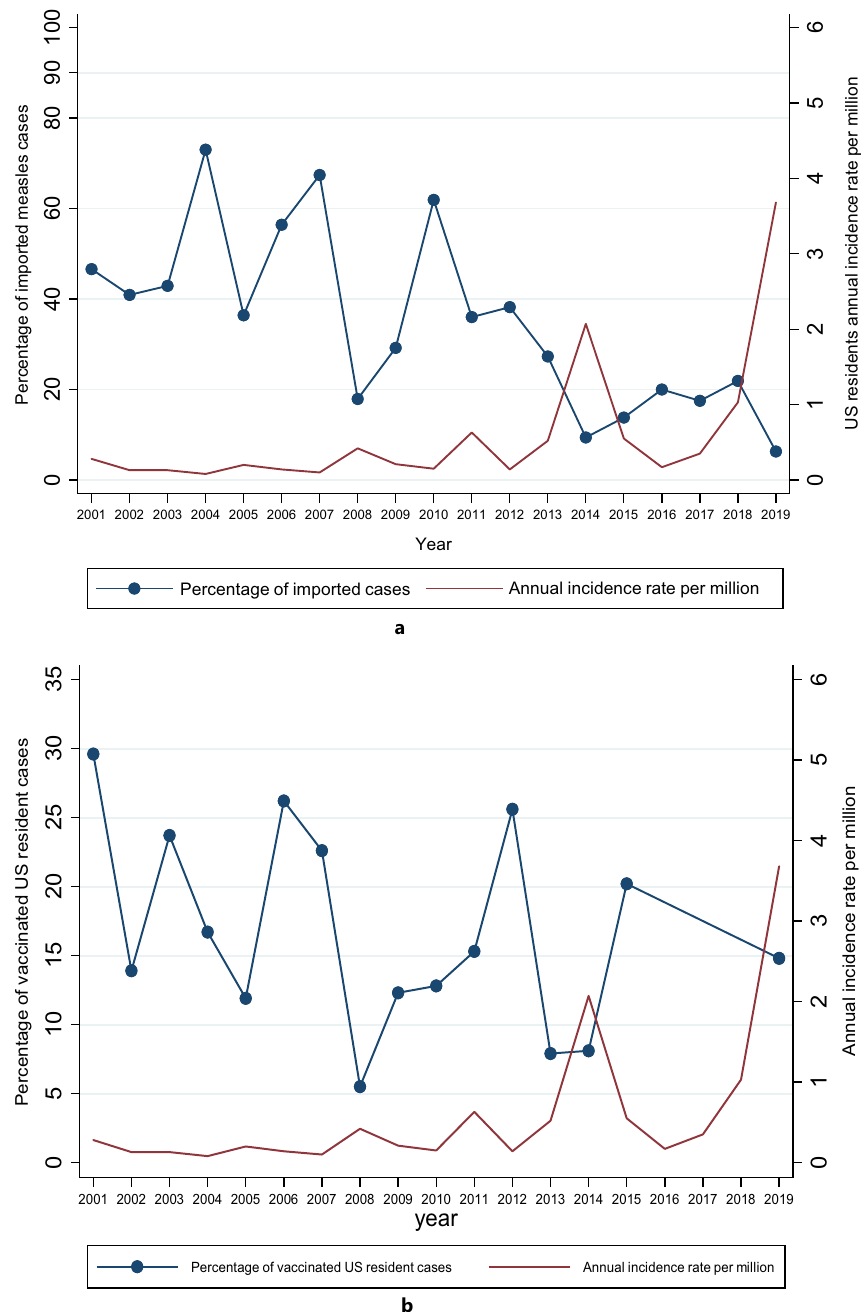
Figure 2. ( a ) Annual incidence rate of measles in US residents and the percentage of imported cases between 2001 and 2019. ( b ) Annual incidence rate of measles in US residents and the percentage of vaccinated cases between 2001 and 2019. The red line represents the annual incidence rate (AIR) per million population and the blue connected line represents the percentage of imported cases and vaccinated respectively. Missing data on the percentage of vaccinated US resident cases for 2016 and 2017 in Fig. 2b. There was a decrease in the percentage of imported cases from 46.6% in 2001 to 6.3% in